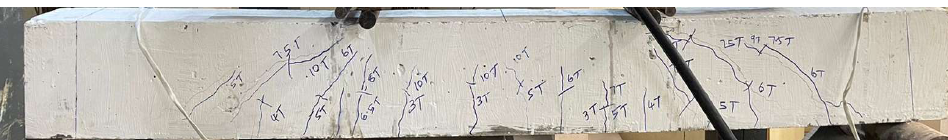
Figure 12. Four layers of 15 mm and 10 mm WWM placed alternatively.